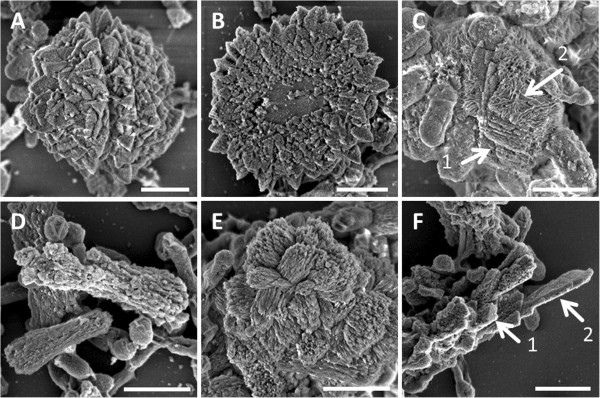
Morphology of mineralization products. Morphological variations of the mineralized CaCO3 after 20 days in medium with and without Zn2+. A) In MH 2 medium triangular CaCO3 platelets were mineralized and assemble into globular agglomerates with equatorial constrictions. B) Cross sections of these agglomerates show the internal construction, which consists of two clearly distinct regions. A smooth inner region is surrounded by an outer region which is composed of triangular platelets and globular particles. The inner region might have been the localization site of bacteria that have been the starting point for particle agglomeration. C) In MH 2Z medium (with Zn2+) particles show a mixed structure of platelet (arrow 1) and sponge like structures (arrow 2). D) In MH 4 medium the initial globular inorganic particles on the bacterial cells elongated and form columnar structures. E) In addition to densely packed needle-like structures. F) In MH 4Z medium only irregular agglomerates consisting of columnar structures (arrow 1) and sheet like structures (arrow 2) are mineralized. Bars represent 1 μm.